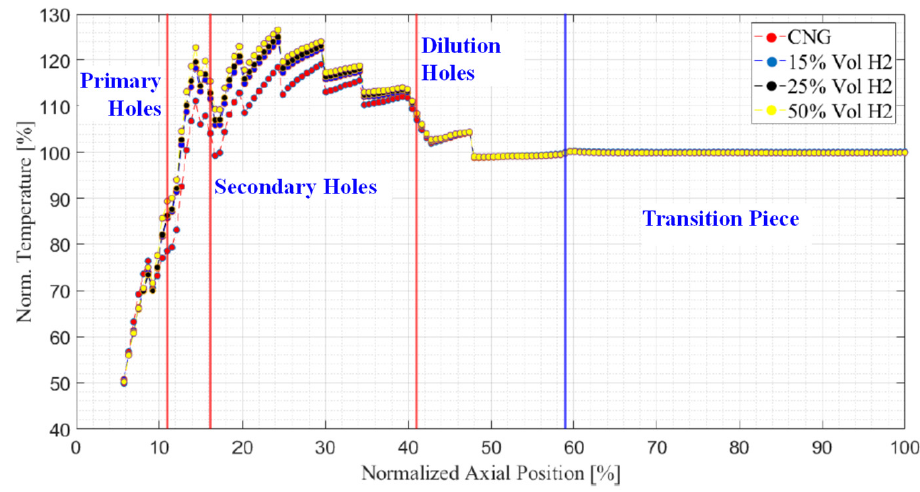
Figure 9. Normalized mass-averaged temperature as a function of the axial position in the basket.